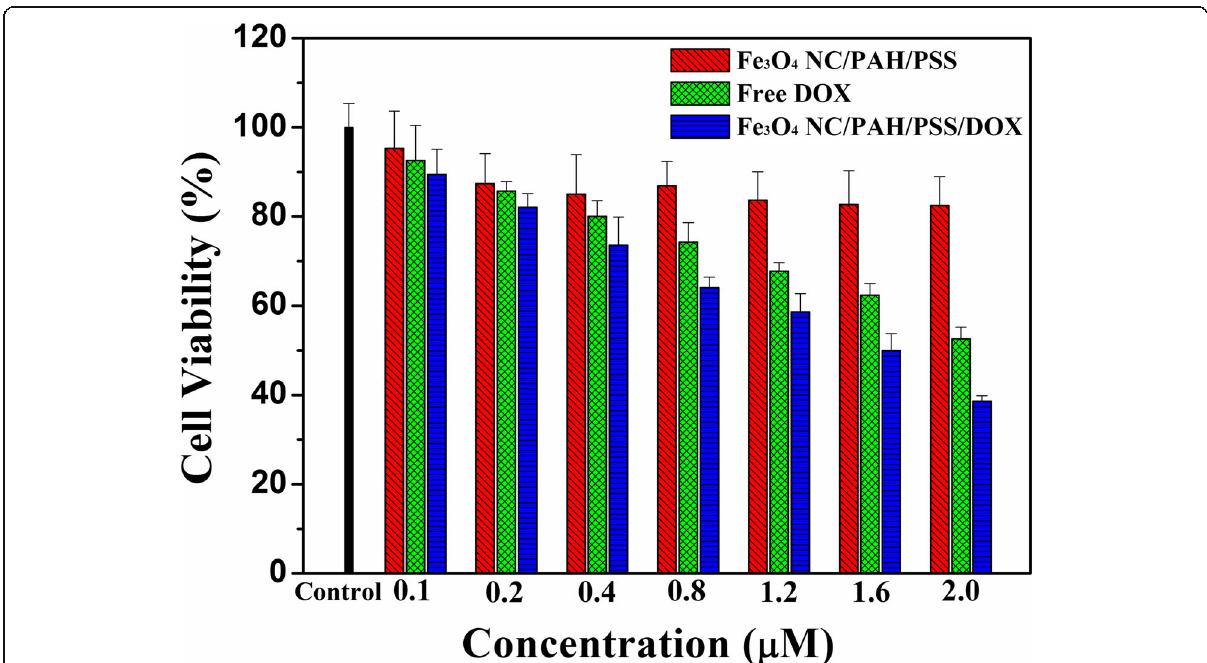
Fig. 7 Relative viability of A549 cells incubated with free DOX, Fe 3 O 4 NC/PAH/PSS, and Fe 3 O 4 NC/PAH/PSS/DOX hybrid nanostructures at different concentrations for 24 h. Error bars were based on triplicate samples